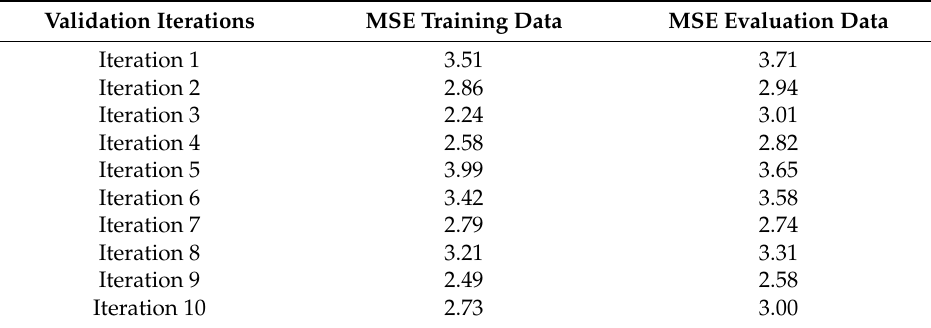
Table 4. Cross-validation of the ANN with 20 hidden neurons .